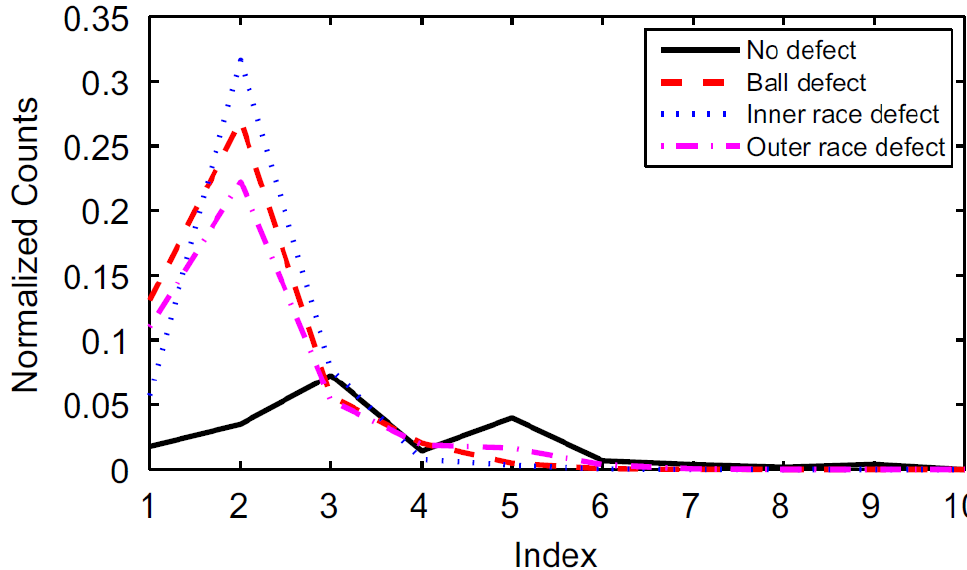
Figure 51. Zero-crossing features characteristics for the diagnosis of multiple bearing faults. Repro- duced with permission of [128]. duced with permission of